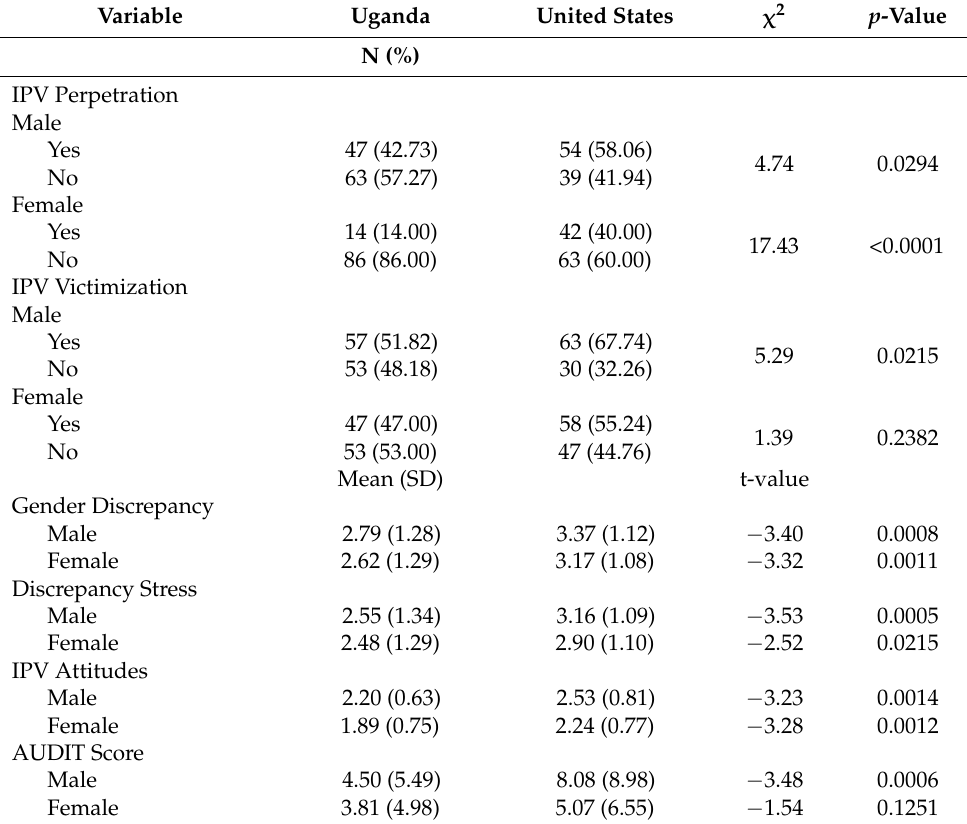
Table 2. Distributions of key variables in Uganda and U.S., stratified by sex (n = 408).